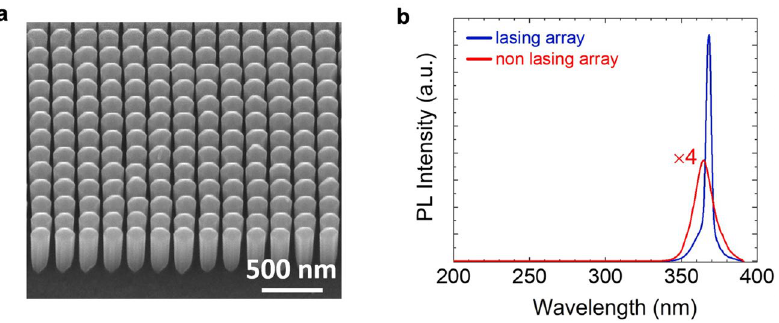
Figure 2. ( a ) A tilted-view SEM image of the NPC structure (the lasing array). ( b ) The RTPL spectra of the lasing and non-lasing arrays. The SEM image of the non-lasing array can be found in Supp.